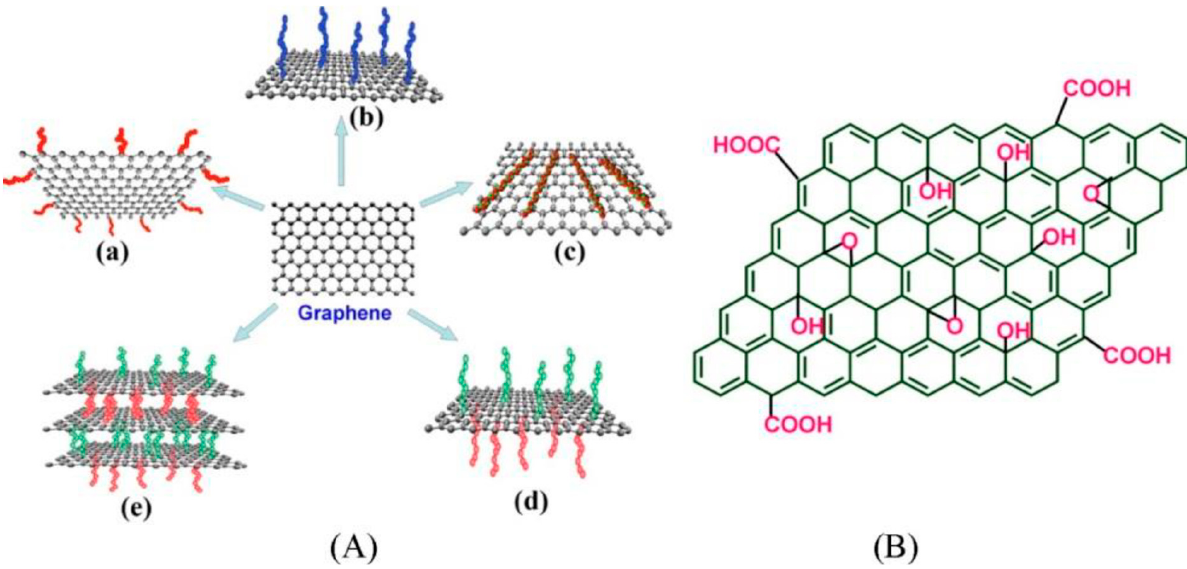
Figure 6. ( A ) Functionalization possibilities for graphene: ( a ) edge functionalization, ( b ) basal plane functionalization, ( c ) non-covalent adsorption on the basal plane, ( d ) asymmetrical functionalization of the basal plane, and ( e ) self-assembling of functionalized graphene sheets, and ( B ) Chemical structure of GO [91].